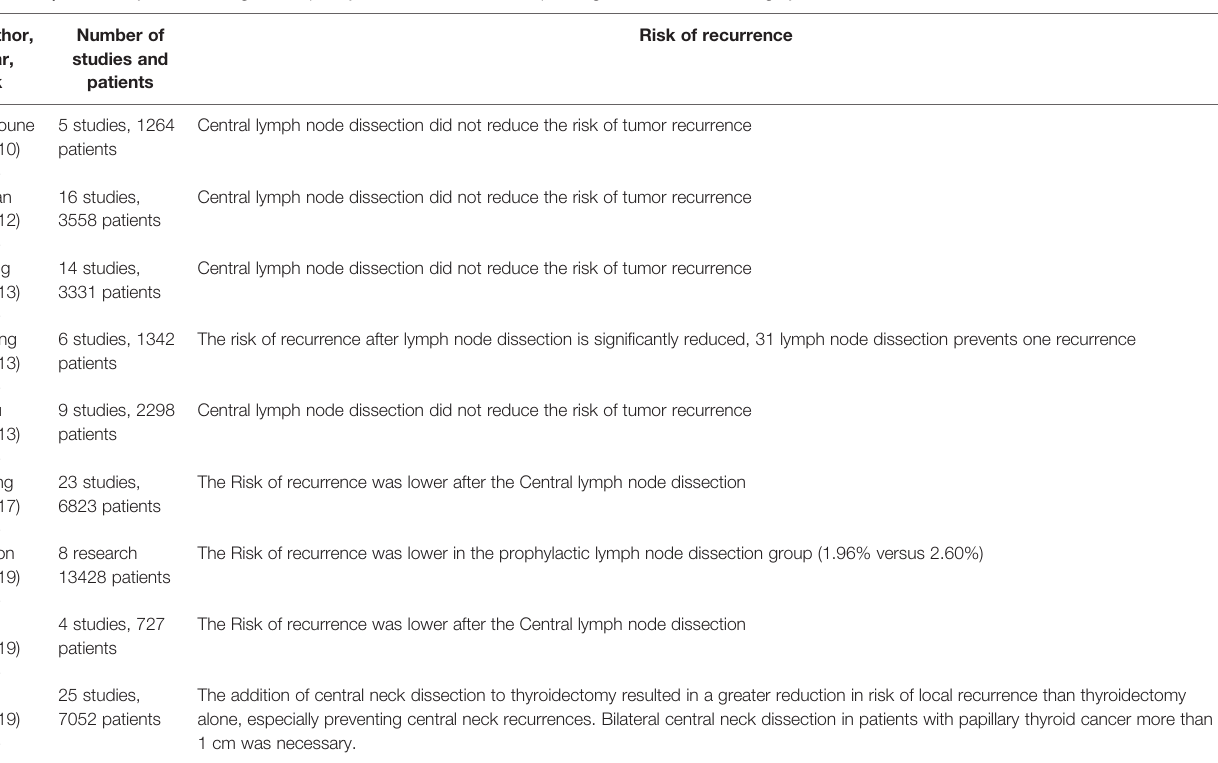
TABLE 4 | Meta-analyses assessing the frequency of cancer recurrence depending on the method of